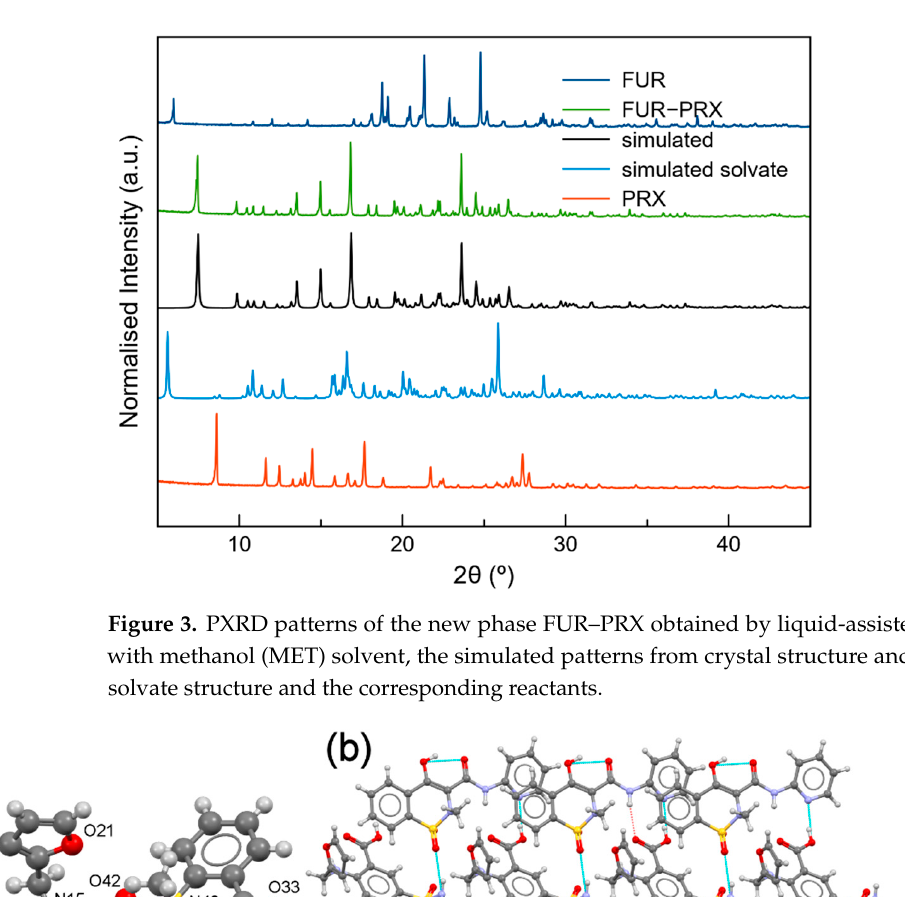
8 of 14 column structure in FUR–ETZ. Carbon bound H atoms omitted for clarity Right. π−π stacking in- teraction in the FUR–ETZ cocrystal. Figure 3 shows a PXRD overlay of the ground and starting materials, as well as the simulated patterns from the single crystal structure and the reported acetone solvate [31]. As shown in this figure, the ground material matches a new single crystal phase, corre- sponding to the FUR–PRX solid form.